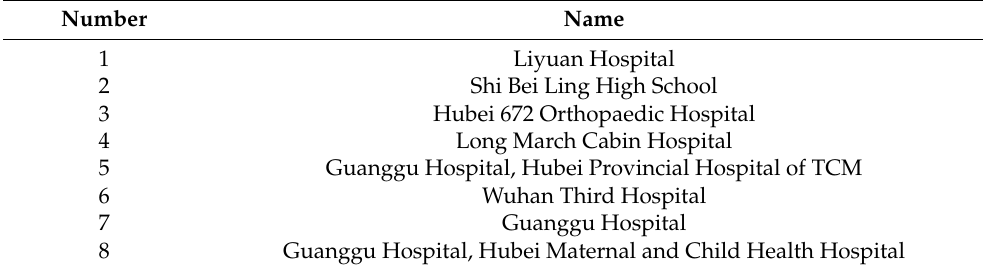
Table 1. Hospitals represented by serial numbers in Figure 2.